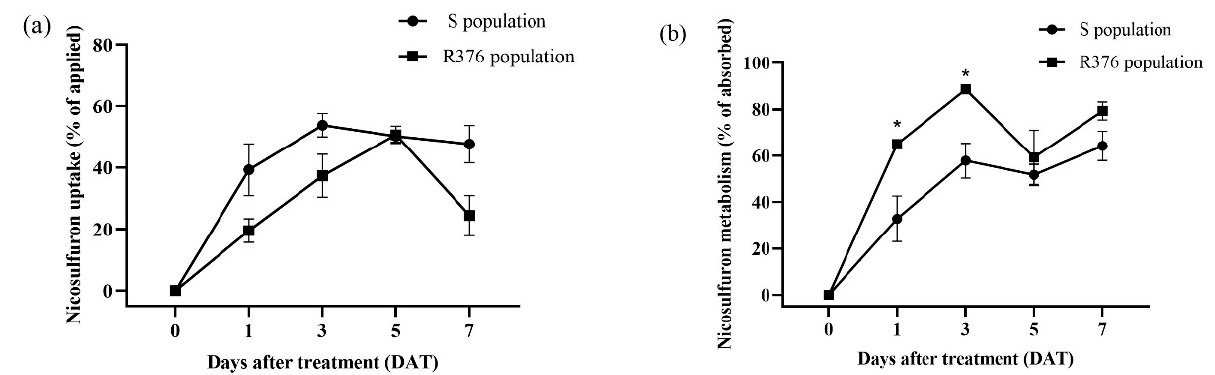
Figure 3. Nicosulfuron absorption ( a ) and metabolism ( b ) in S and R376 populations of S. viridis . * * p < 0.05. p < 0.05